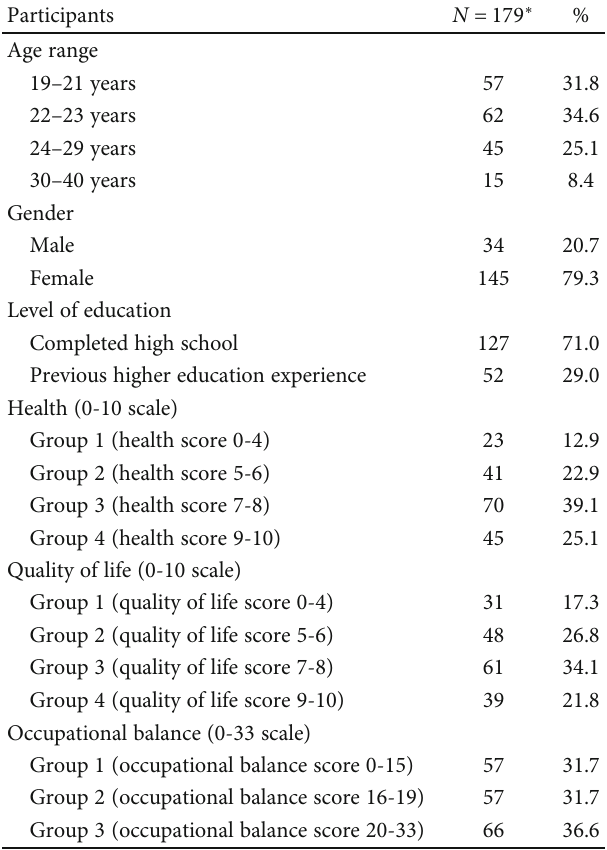
Table 1: Participant